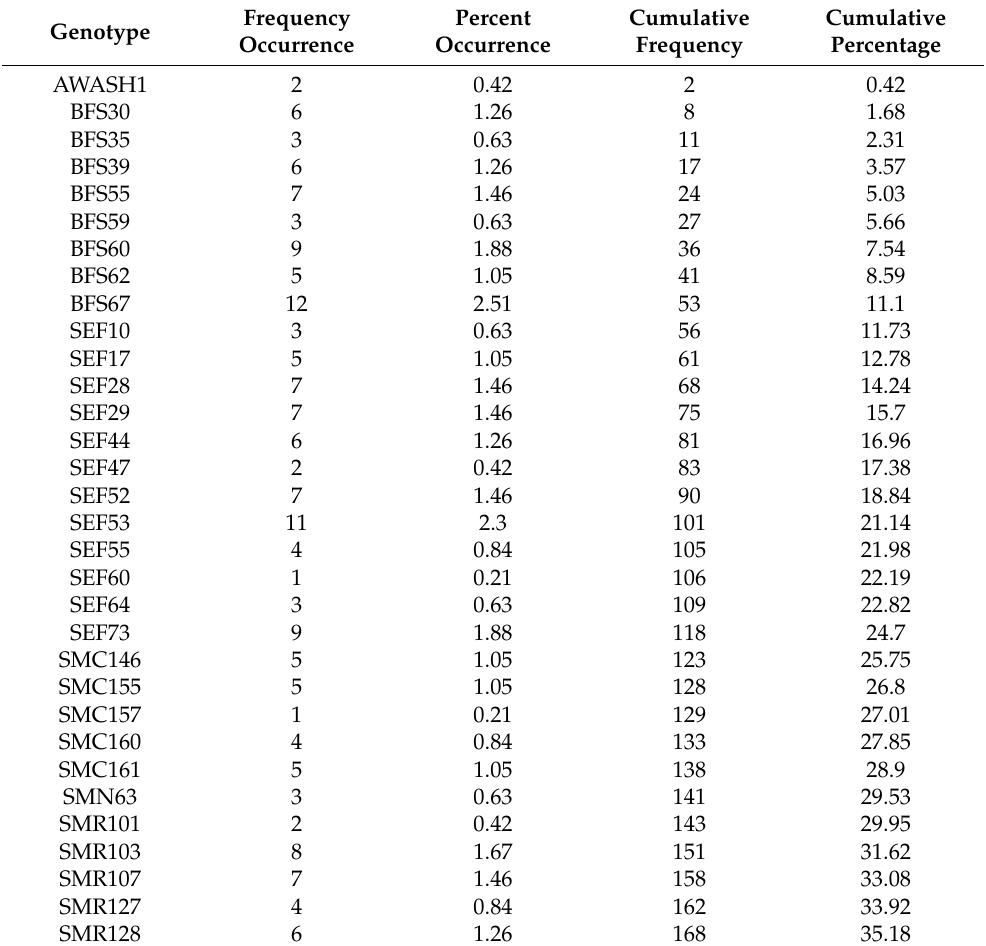
Table 8. Pod abortion frequency of drought-tolerant common bean accessions during termi- nal drought. Frequency Genotype